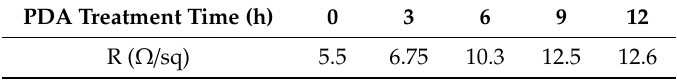
Table 2. Electrical resistivity of the dopamine-treated Ag-coated samples.